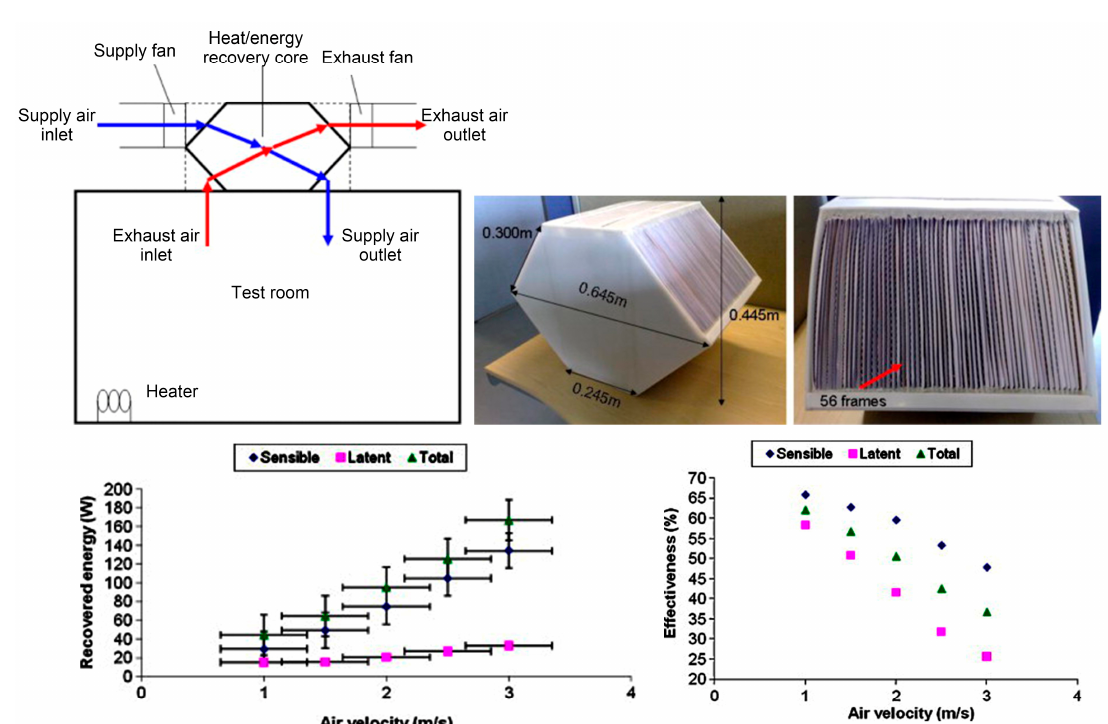
Figure 5 . Graph results for an air-to-air enthalpy heat exchanger [20] .